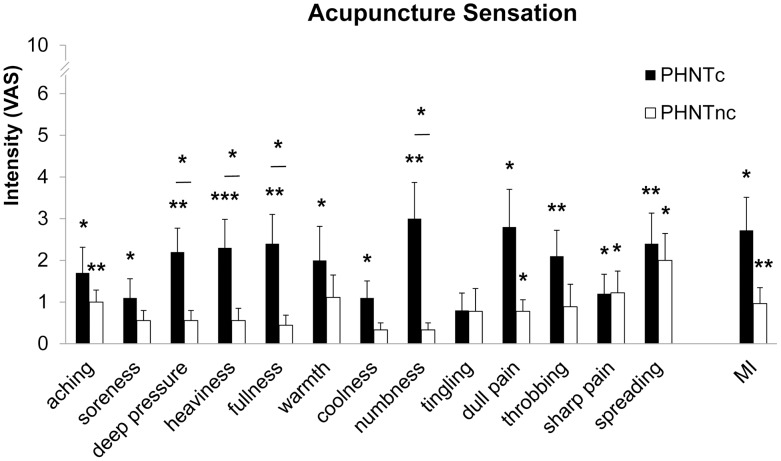
Influence of credibility on acupuncture sensations to phantom acupuncture.PHNTc reported significantly greater sensation intensity for numbness and dull pain (i.e. deqi sensations). n.b. *<0.05, **<0.01, ***<0.001. Error bars represent standard error of the mean.